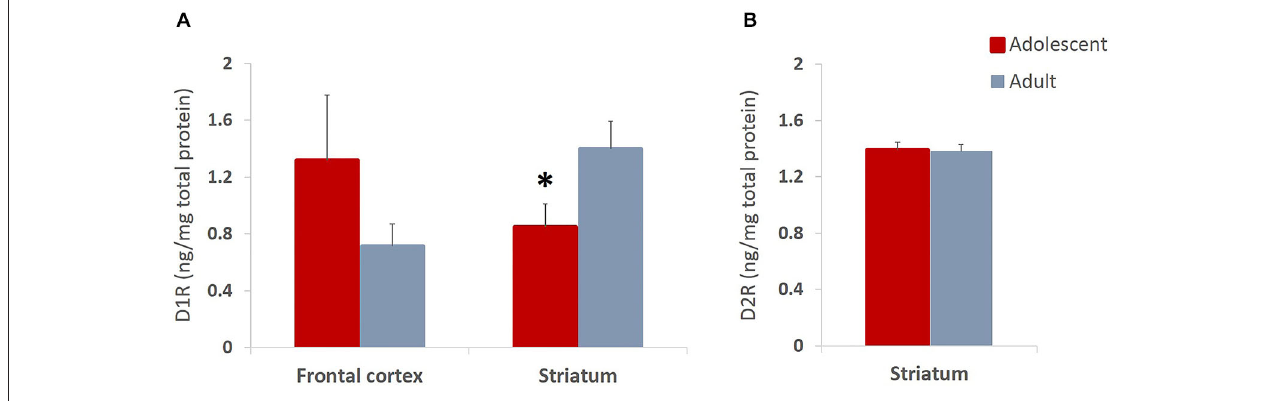
of animals that had experiences with reward learning during adolescence compared to animals that went through the same learning in adulthood. (B) The levels of D2 receptor expression were not different between the animals that underwent behavioral testing during adolescence or adulthood. * p < 0.05.